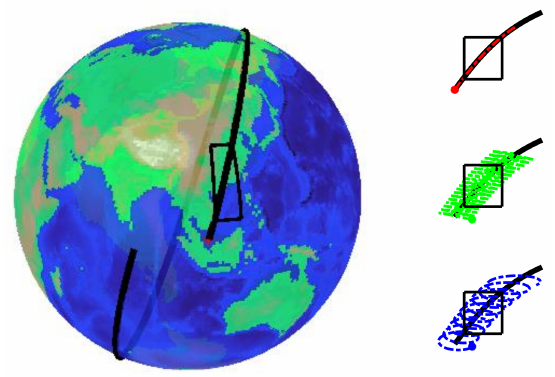
Figure 5. A diagram of the three scanning imaging modes.